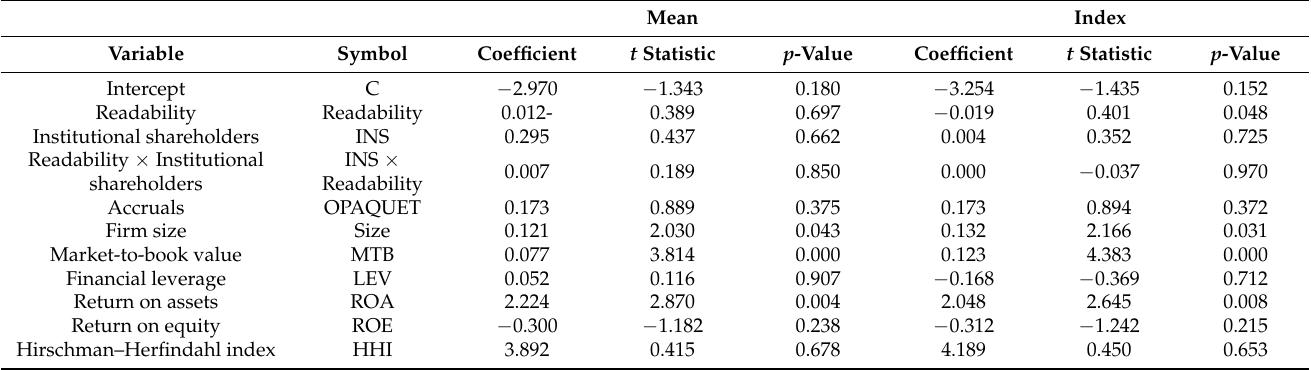
Table 8. The result of the second model by changing the index related to the institutional shareholders.